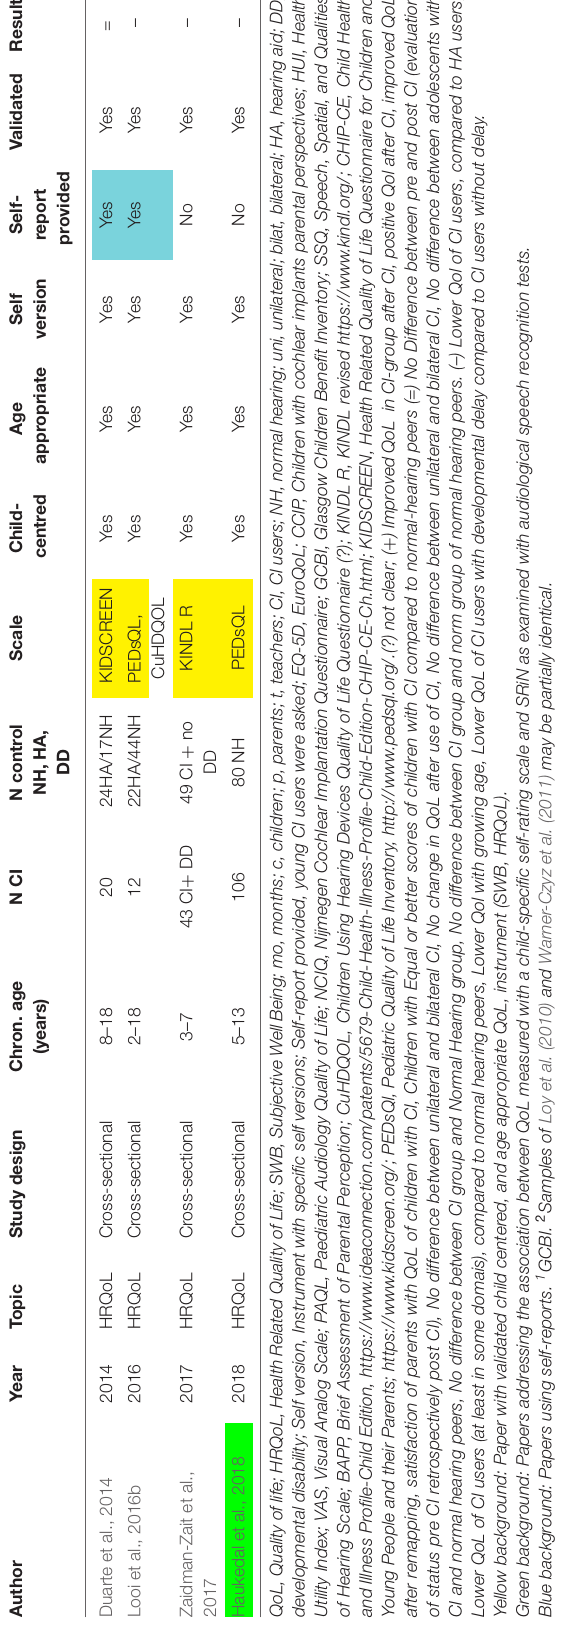
Table 1 . 3 “Mapping (or MAPping) is the term for programming a cochlear implant to the specifications and needs of its use” (http://cochlearimplantonline.com/site/